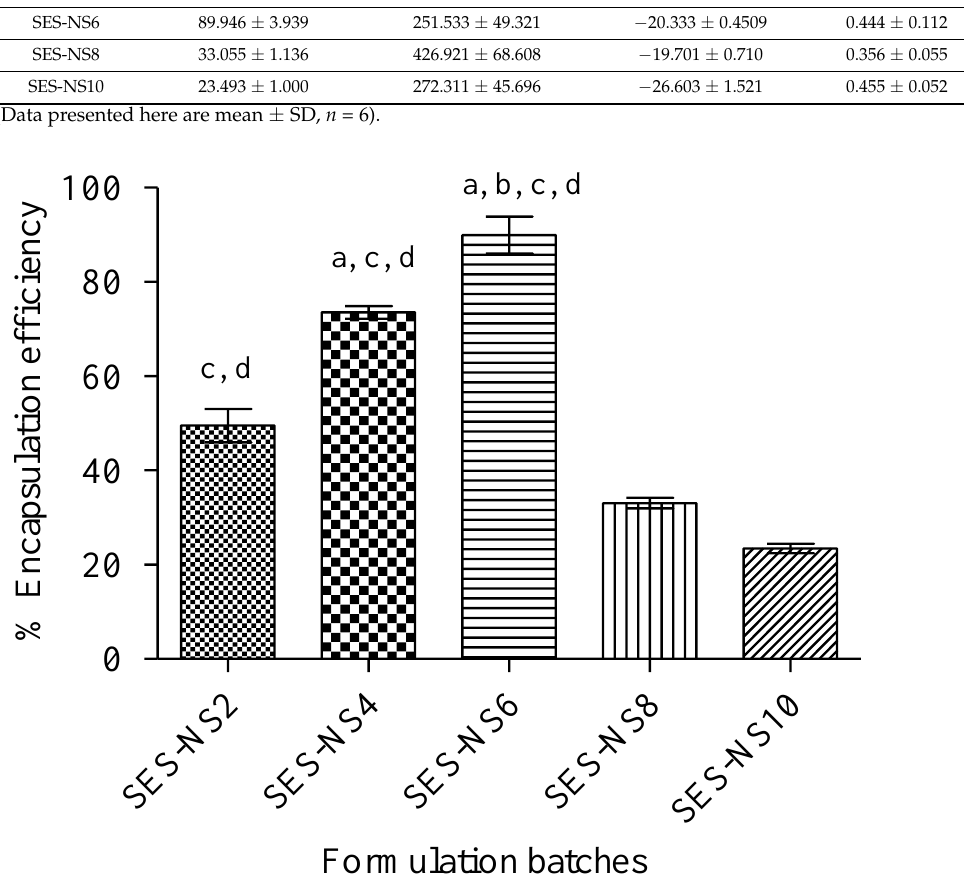
Figure 2. Encapsulation efficiency of SES–NS batches (1:2-1:10). Data reported here represent mean ± SD (n = 6). A one-way ANOVA statistical data analysis was followed by a Tukey’s test for multiple comparisons. (a) p < 0.001 vs. SES-NS2; (b) p < 0.001 vs. SES-NS4; (c) p < 0.001 vs. SES-NS8; (d) p < 0.001 vs. SES-NS10. SES: Sesamol; SES-NS: Sesamol-laden NS.